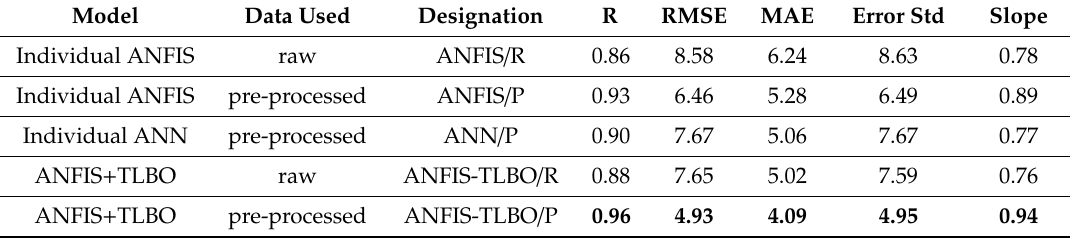
Table 4. Comparison of prediction capability of different models using raw and pre-processed data, respectively. Correlation Coefficient (R), Root Mean Squared Error (RMSE)